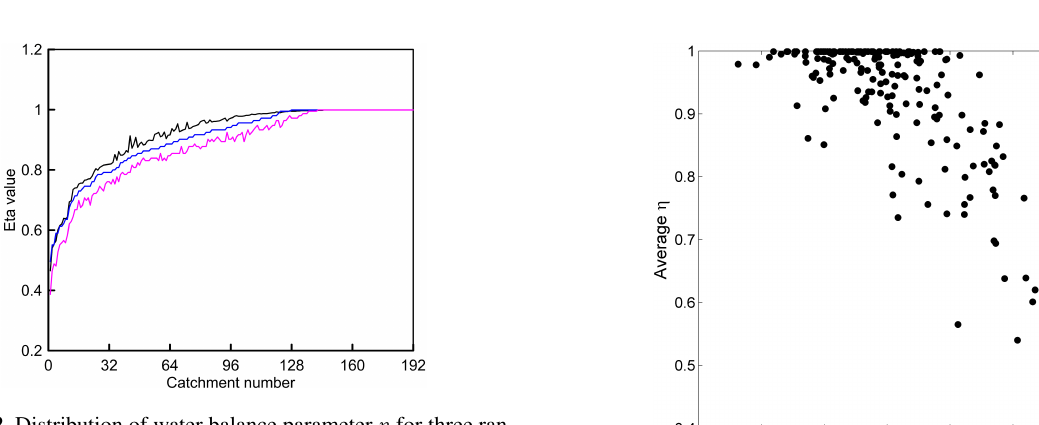
Figure 12. Distribution of water balance parameter η for three ran- domly selected common parameter vectors obtained via HBV using the NS performance measure for 192 selected catchments.